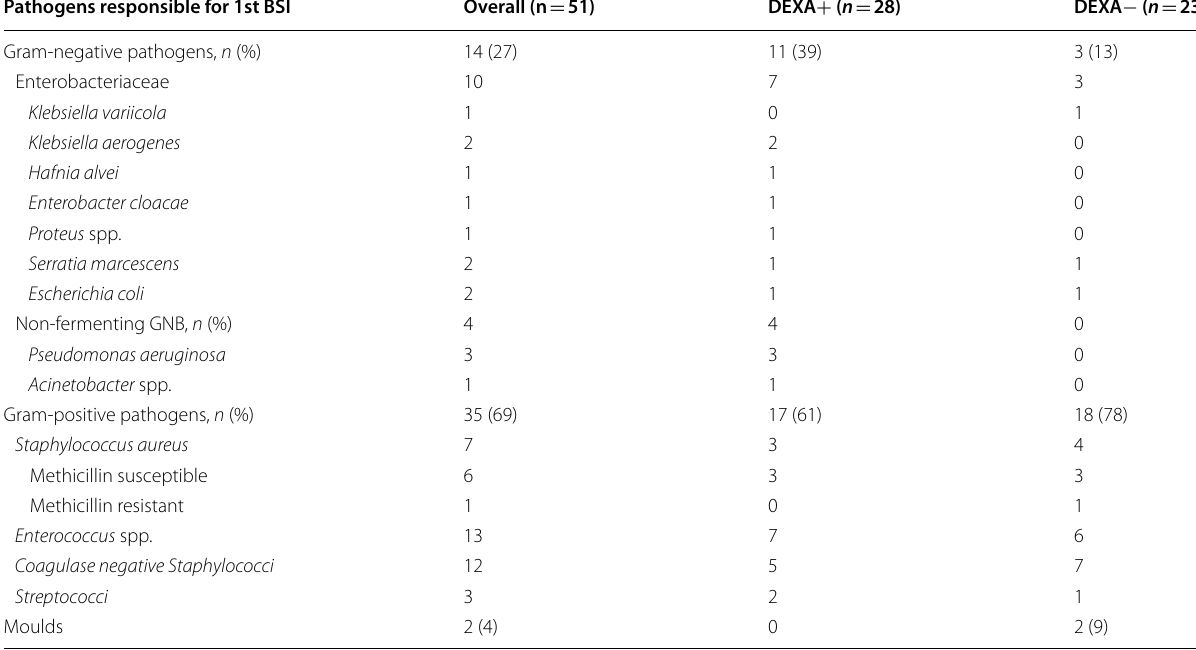
Data are presented as absolute value and percentage